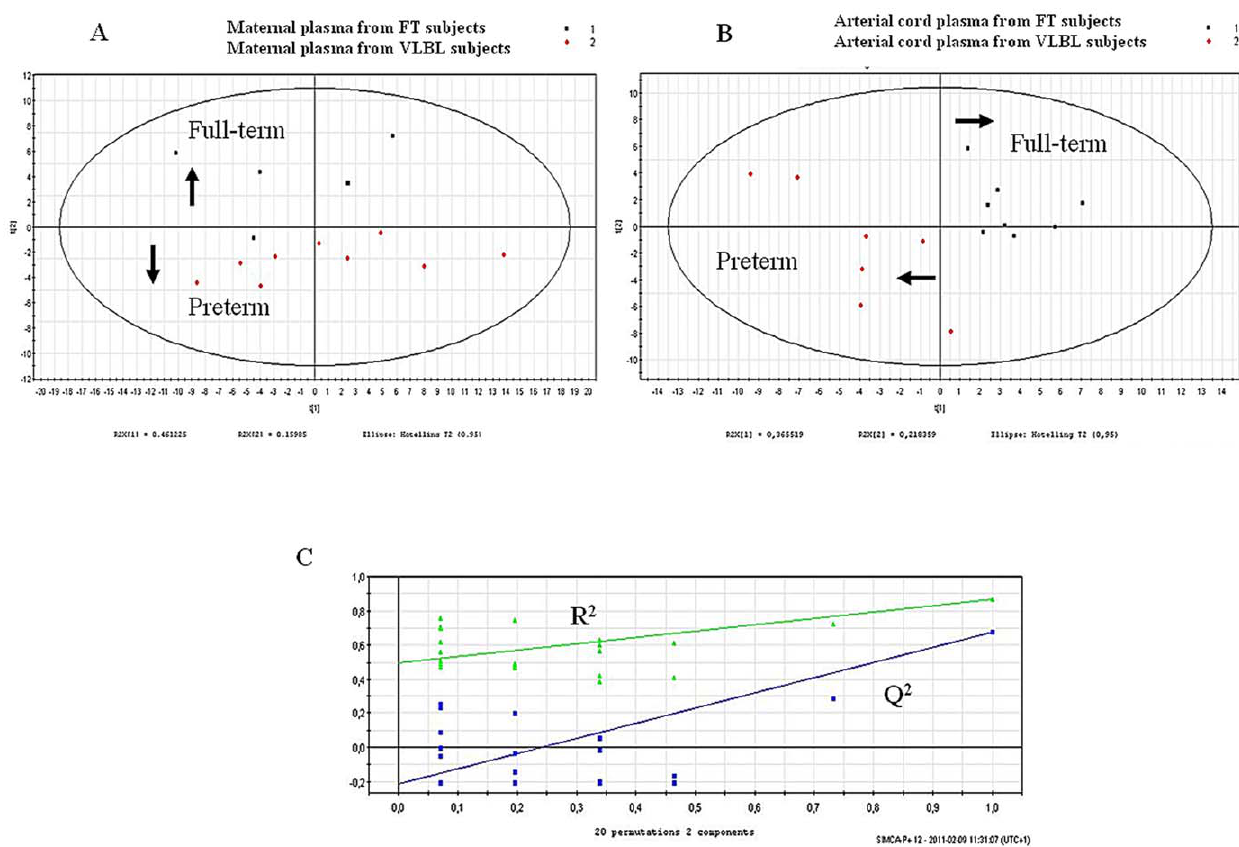
Figure 6. Multivariate analyses resulting from the standard 1D 500 MHz 1 H NMR spectra from FT and VLBW preterm deliveries. (A): PCA scores plot resulting from the analysis of maternal plasma. (B): PLS-DA scores plot resulting from the analysis of arterial umbilical cord plasma and validation by permutation test (C). (C): R 2 (X)=0.366, R 2 (Y)=0.695 and Q 2 (Cum)=0.676. The model has been validated by a permutation test (n=20). R 2 intercept is at 0.495 and Q 2 intercept is at 2